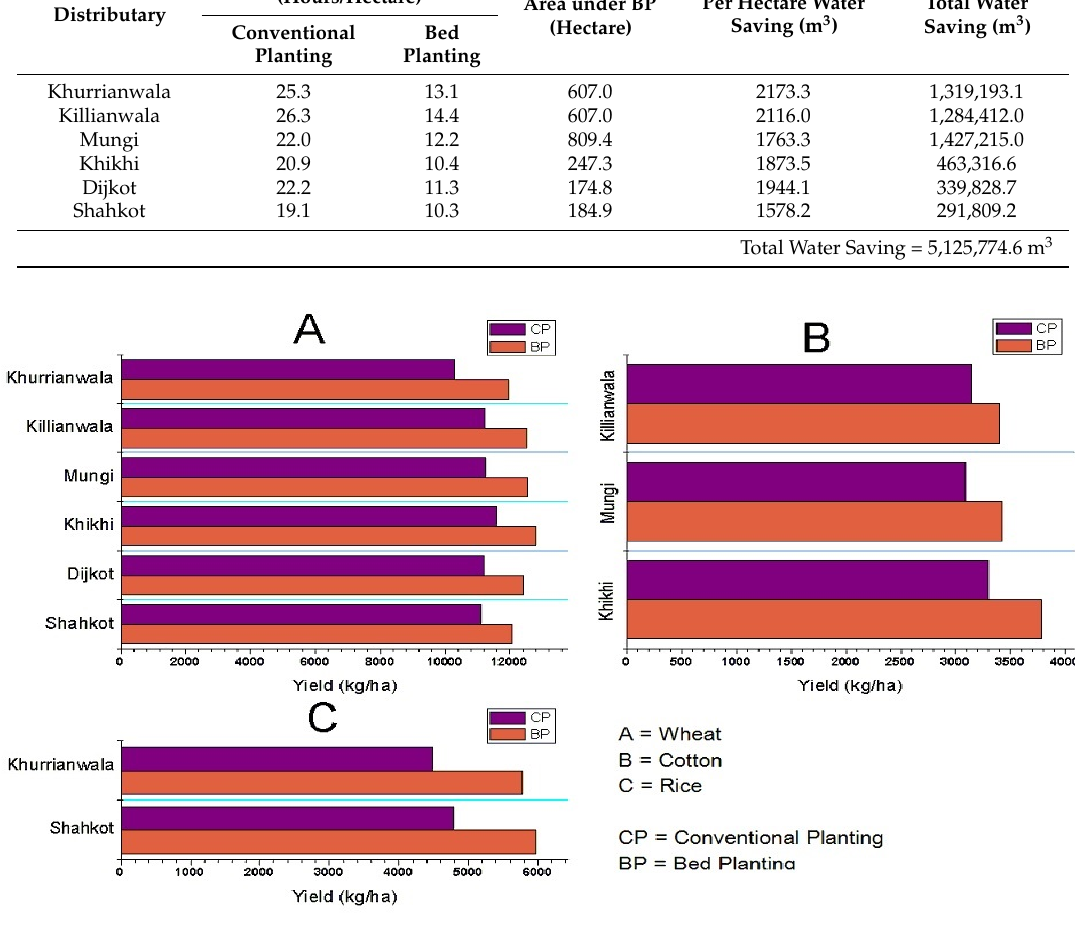
Figure 9. Yield comparison of wheat, cotton and rice under BP and CP.